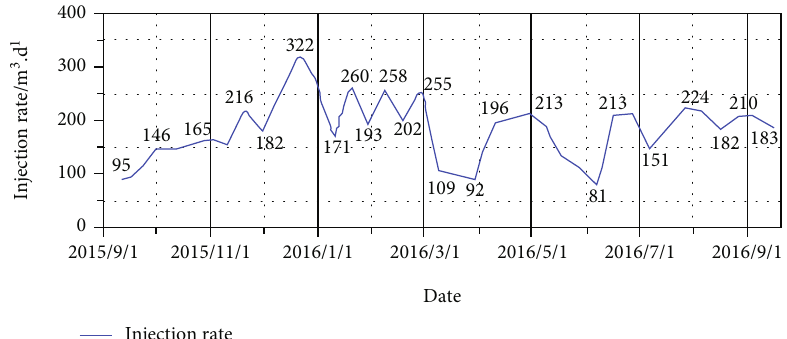
Figure 5: The record of injection rate data.